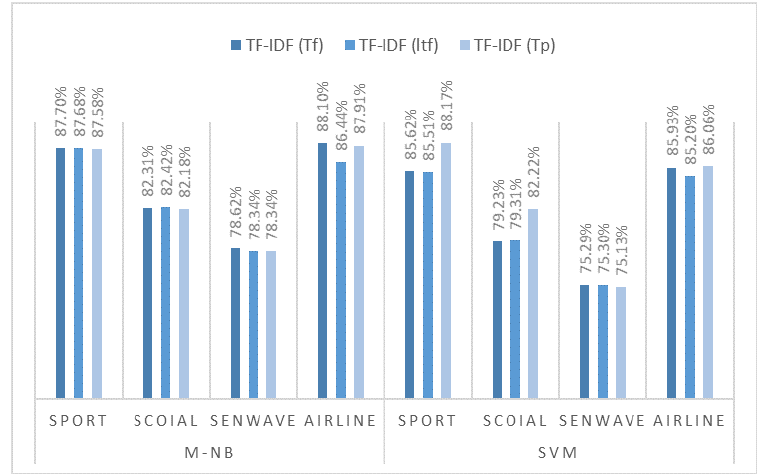
Figure 4. TF-IDF using different local factors.